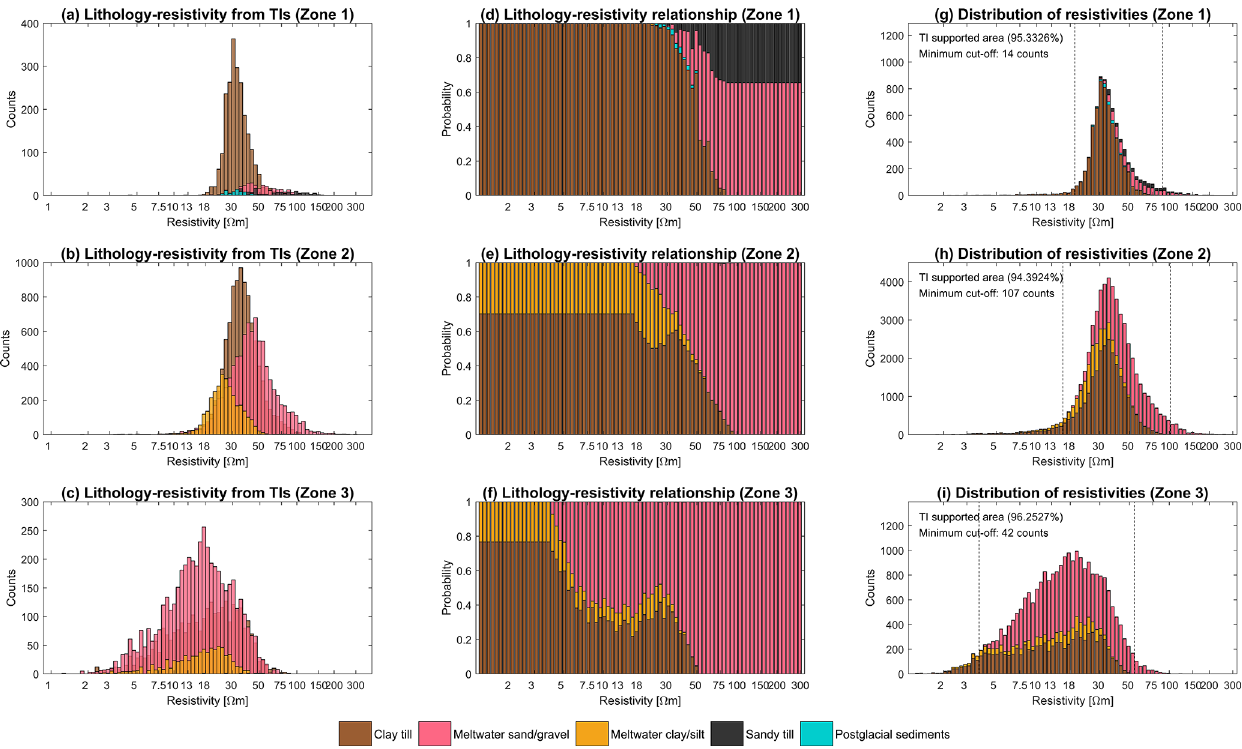
Figure 8. Resistivity–lithology relationships illustrated as (a–c) histograms of resistivity for each lithological group based on the training images (Fig. 4) and the corresponding values in the 3D resistivity grid (Fig. 7), (d–f) TI-based cumulative distribution for all lithological groups for each bin and a priori relationship for rare resistivities and (g–i) distribution of resistivity values in the corresponding zone in the simulation grid (Fig. 9f) overprinted with the lithology–resistivity relationship established in (d–f)